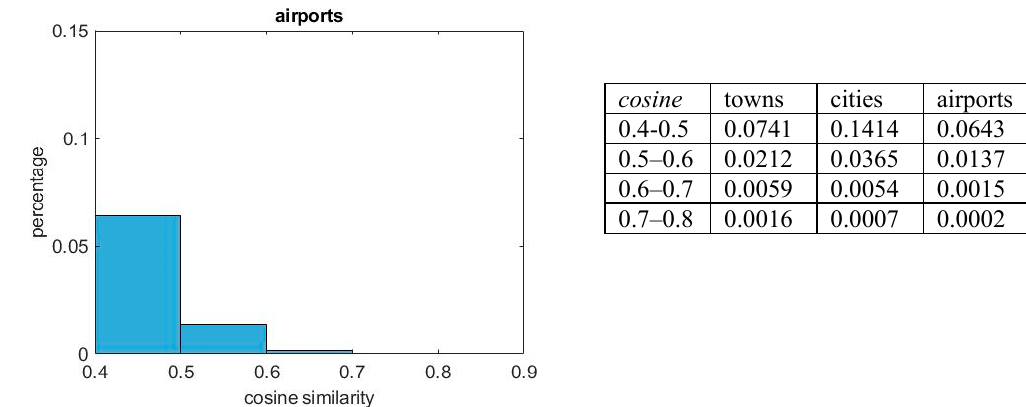
Figure 12. Similarity distribution of towns, cities and airports in the slot cos = 0.4–0.9. Towns present higher percentages for high similarity slots, cities for mid-low similarity slots, and airports for very low slots.